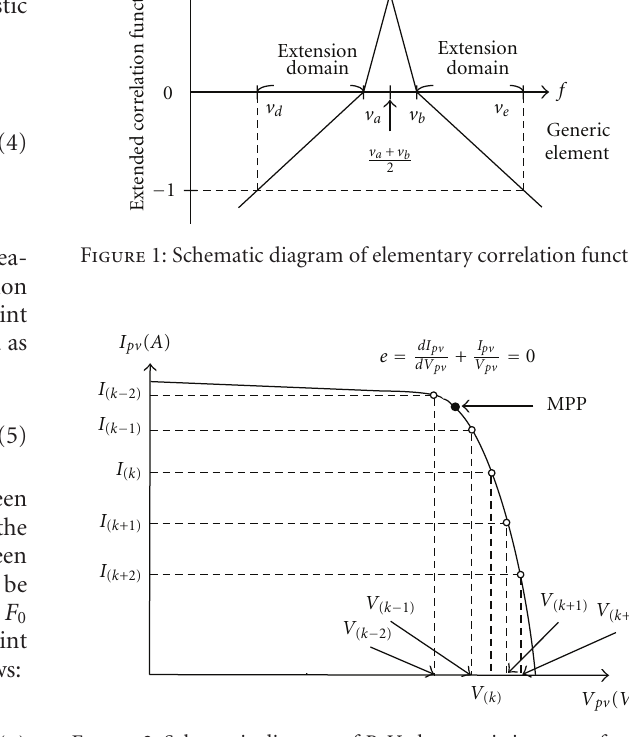
Figure 2: Schematic diagram of P - V characteristic curve of output voltage and corresponding output power of a PV module